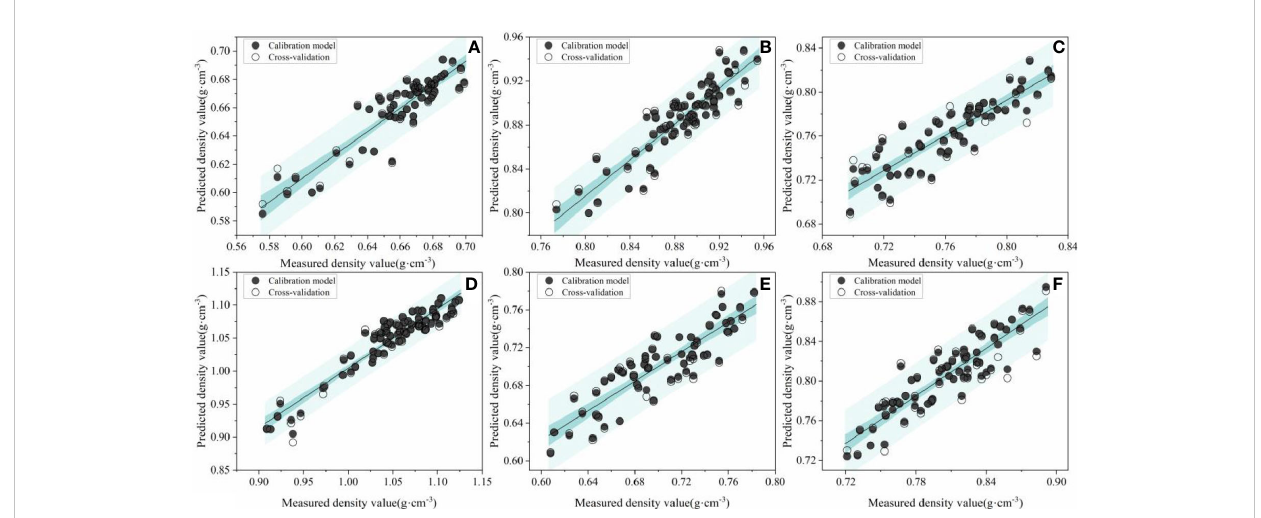
FIGURE 11 The scatter plots of predicted and measured values for RSM-PSO-SVM models. (A – F) are Tilia tuan Szyszyl., Acer mono Maxim, Chinese white poplar (Jilin), Japanese elm, Chinese white poplar (Heilongjiang), and Dahurian larch,